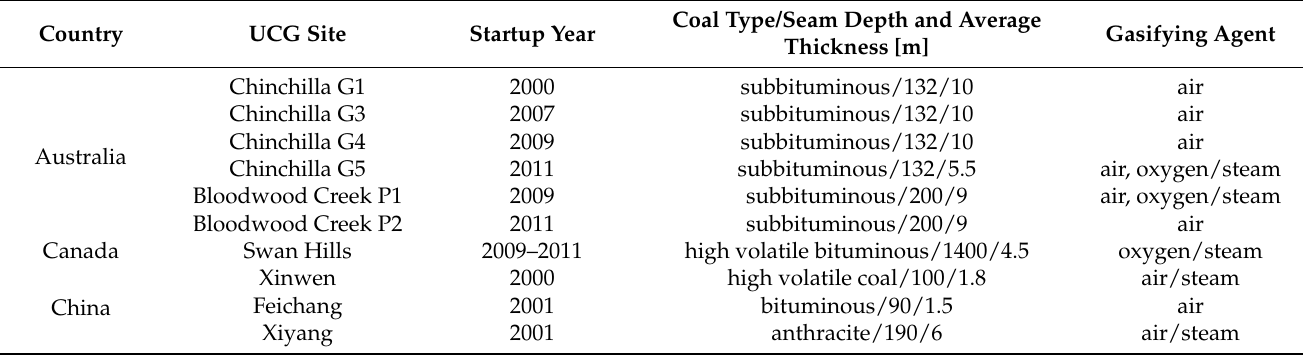
Table 2. Worldwide significant UCG experiments in situ after year 2000 (from [4] with some modi- fications).